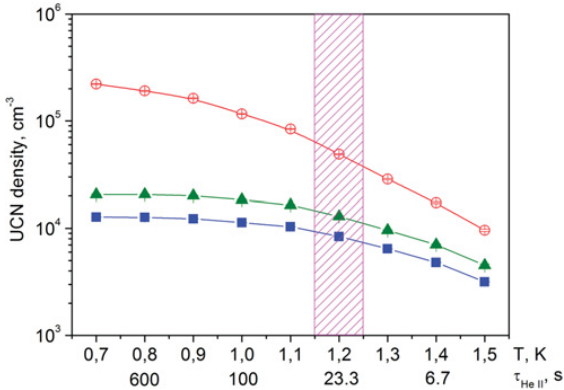
Figure 2. UCN density as a function of the He-II temperature • – in the closed source chamber, (cid:1) – in a 35-l external trap, (cid:2) – in a 350-l external